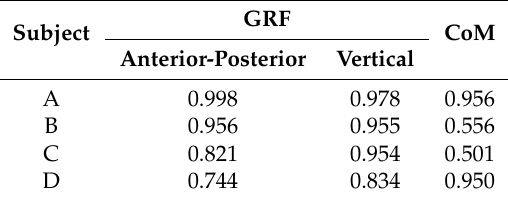
Table 4. S M index for the GRFs and the vertical